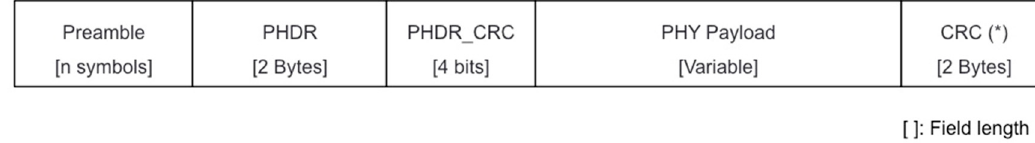
Figure 3. LoRaWAN physical layer message format. (*) Cyclic Redundancy Check (CRC) field is only present in uplink transmissions. The preamble length is configurable; for the device used in this study, preamble length is n = 8